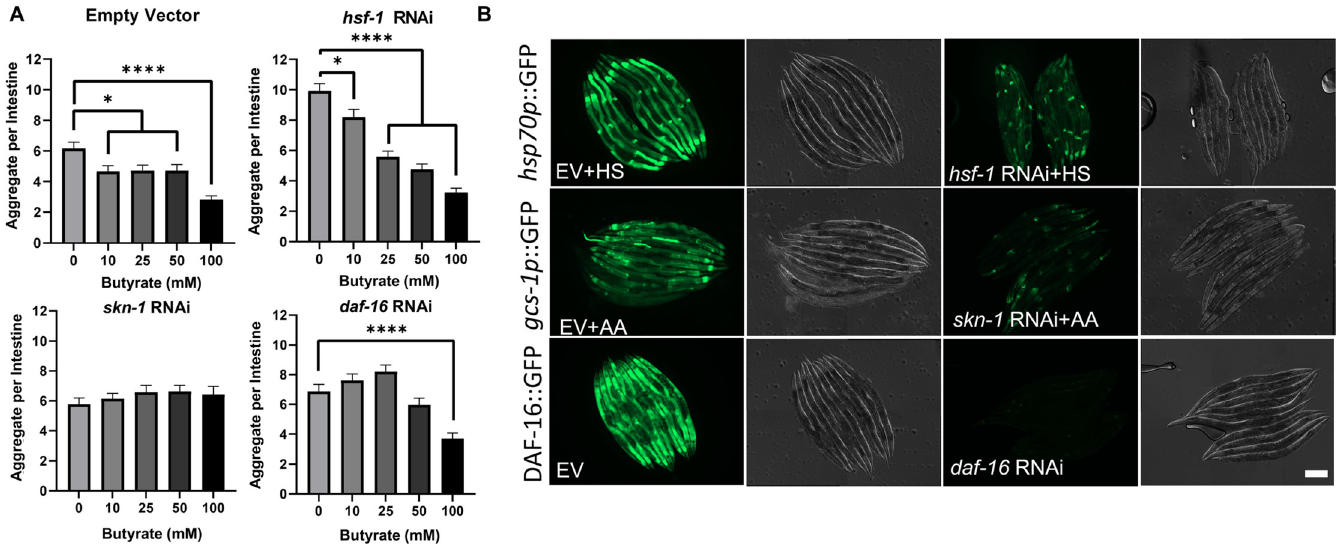
Fig 7. SKN-1 and DAF-16 are involved in butyrate-mediated suppression of aggregation. A) The effect of hsf-1 , skn-1 , and daf-16 knockdown on intestine-specific polyQ44 aggregation in the presence of exogenous butyrate supplementation, compared to empty vector control (L4440). Data are represented as the average number of aggregates per C . elegans intestine. Each data point is an average of a minimum of three independent experiments with a total of at least 85 animals. Error bars represent SEM. Statistical significance was calculated using one-way ANOVA followed by multiple comparison Dunnett’s post-hoc test ( � p < 0.05, ���� p < 0.0001). B) Fluorescent and Nomarski images of worms expressing reporter constructs regulated by HSF-1, SKN-1, and DAF-16. Worms were fed E . coli expressing either the control empty vector (EV) shown in the left panels or specific RNAi shown in the right panels. To activate the reporters, animals expressing hsp70p ::GFP and gcs-1p ::GFP were either heat shocked (HS) or exposed to 5 mM acrylamide (AA), respectively. Functional knockdowns were confirmed by the attenuated GFP expression in animals fed RNAi versus EV. Scale bar = 200 μ m.